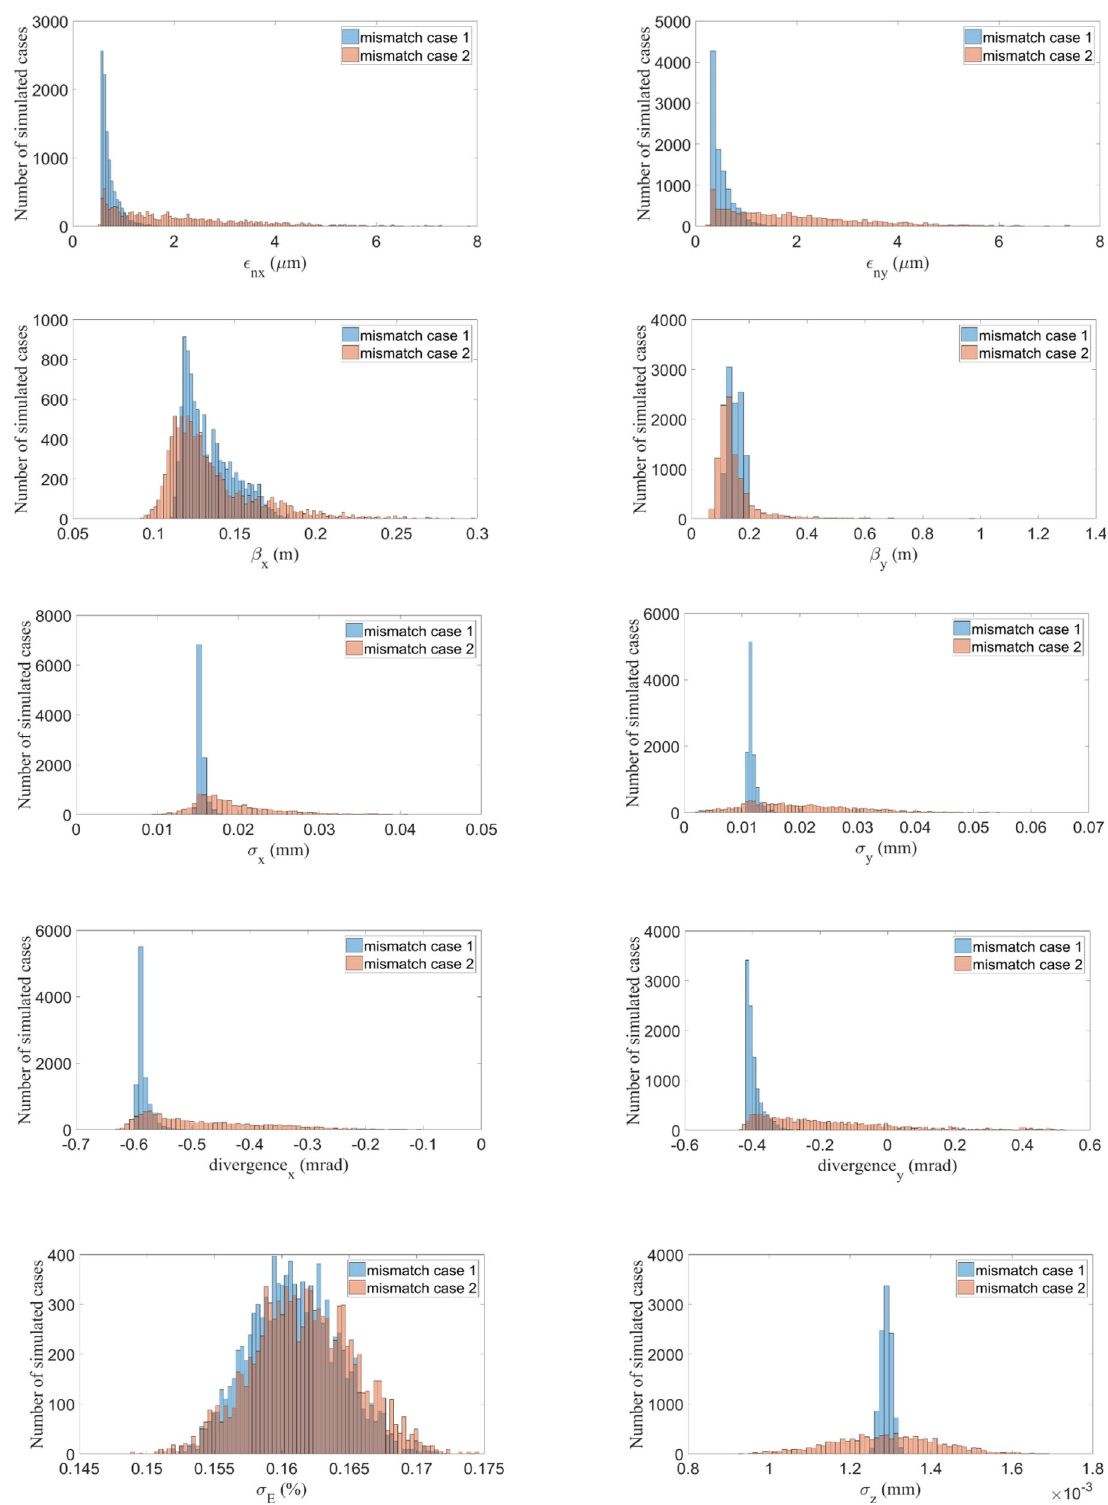
FIG. 7. Variation in observed beam parameters at the plasma entrance for the two error scenarios defined in the text (mismatch cases 1 and 2). 10,000 random cases are simulated for each